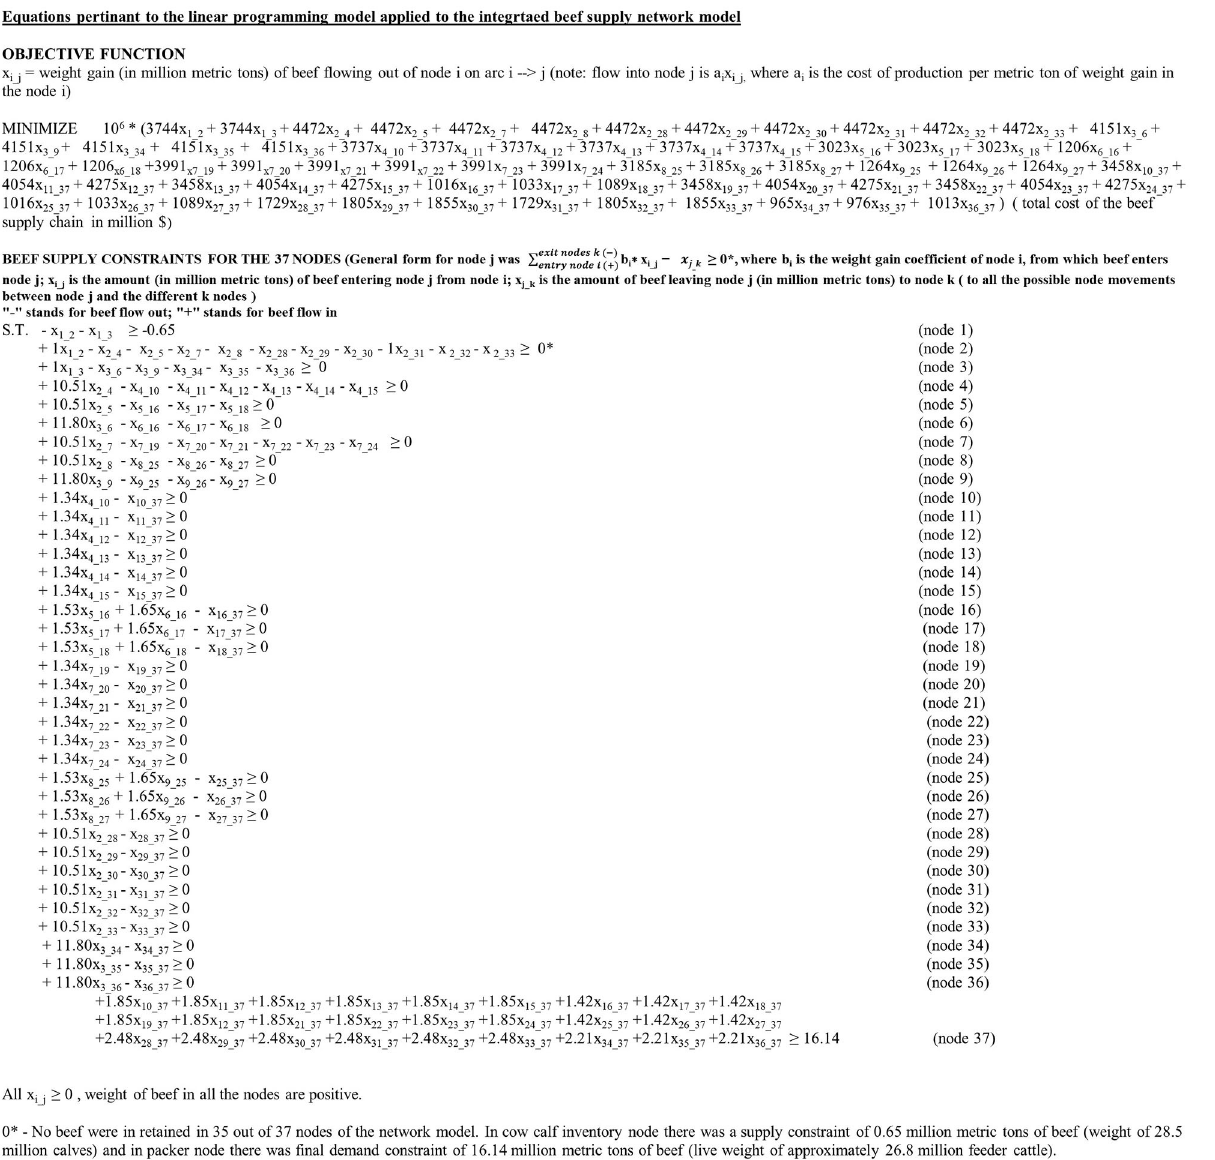
FIGURE 2 | The objective function as well as the 37 different constraint equations for the linear programming model applied to the integrated beef supply chain network model.